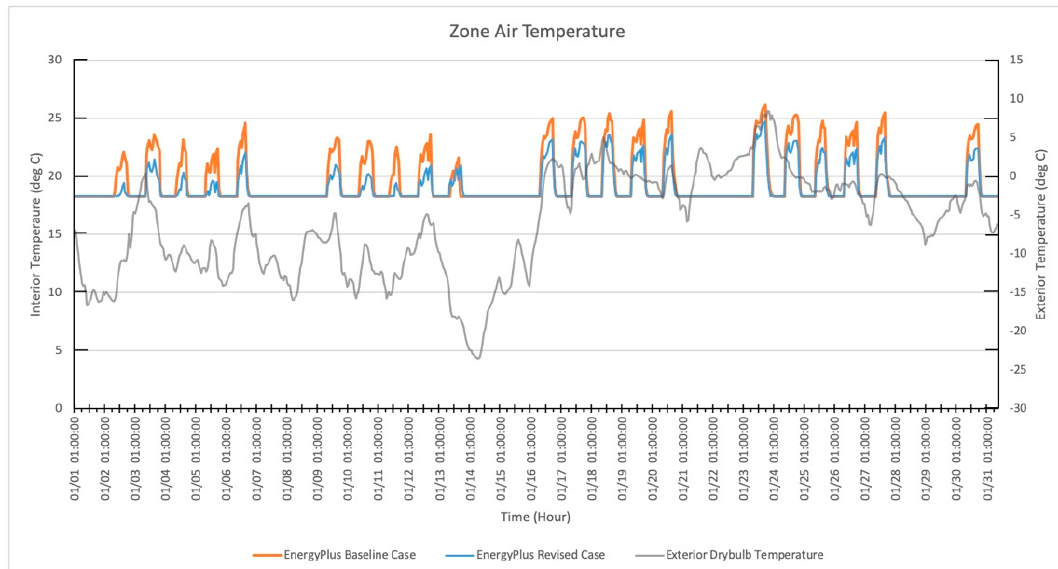
Figure 9. EnergyPlus temperature results in January with baseline case (red) and revised case 2 (blue) showing a reduction in temperature when outdoor airflow rate is increased.